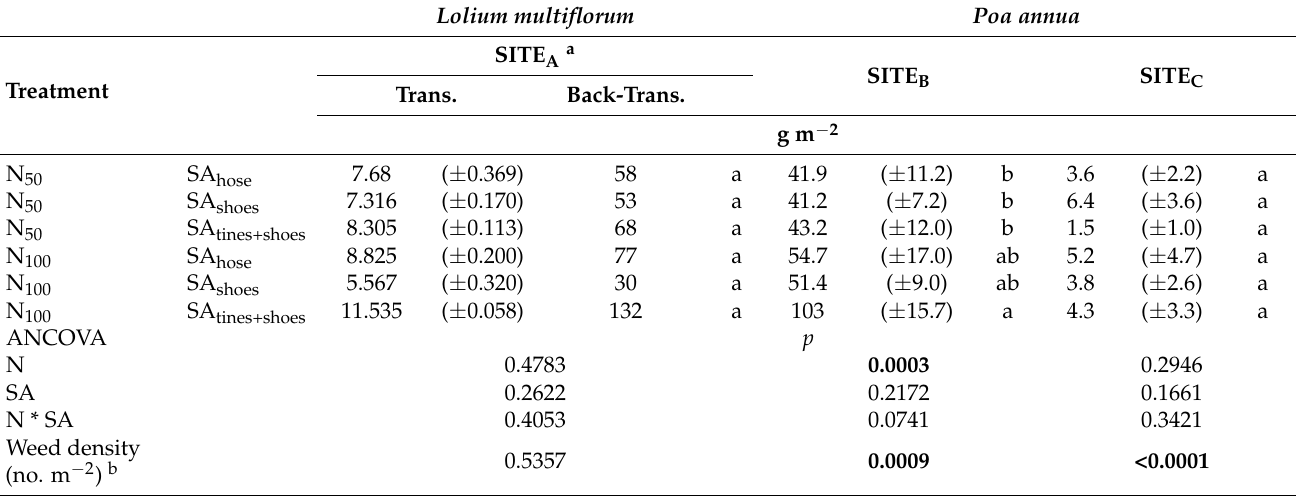
Table 5. The effect of nitrogen rate (N 100 and N 50 ) and slurry application method (SA hose , SA shoes , and SA tines+shoes ) on intra-row fibrous-rooted Lolium multiflorum (SITE A ) and Poa annua biomass (SITE B and SITE C ). Data from each site were analyzed separately. A connecting letters report displays differences among treatments, whereby means not sharing a similar letter are significantly different ( p < 0.05). Significant main effects and interactions are highlighted in bold text ( p < 0.05). Standard errors are displayed in parentheses.